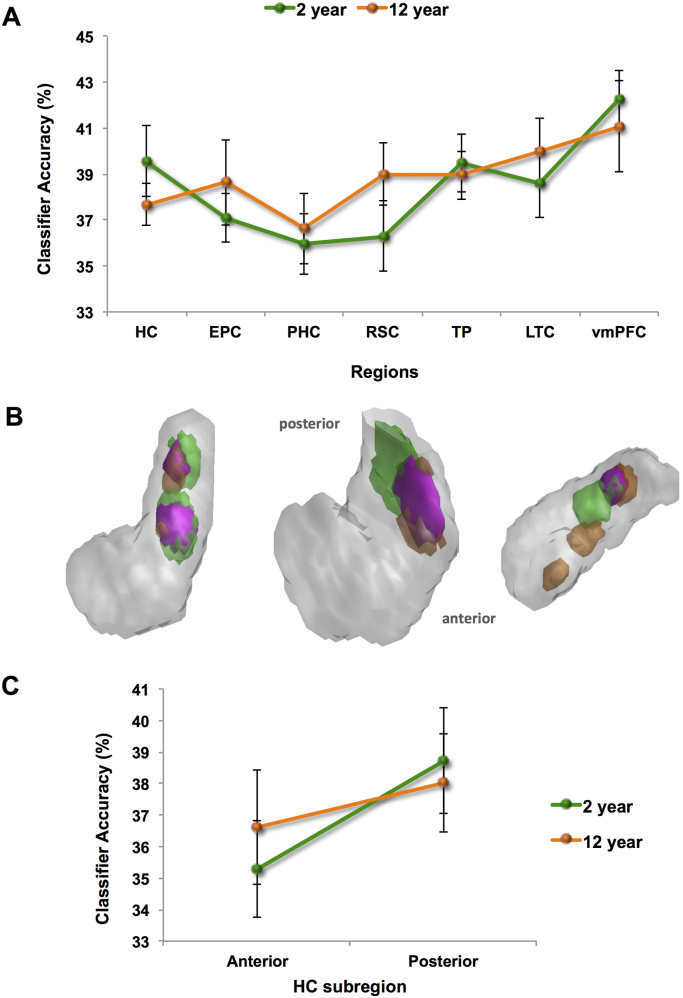
MVPA results for recent and remote autobiographical memories in study two. A. Hippocampus (HC), entorhinal and perirhinal cortices (EPC), parahippocampal cortex (PHC), retrosplenial cortex (RSC), temporal pole (TP), lateral temporal cortex (LTC), and ventromedial prefrontal cortex (vmPFC) were examined. Chance=33%. Two year old (green line) and 12 year old (orange line) autobiographical memories were represented in medial temporal regions, including the hippocampus. In study two, this was also the case for vmPFC. Error bars represent ±1 standard error of the mean. B. Information maps in the hippocampus for 2 year old (shown in green) and 12 year old (shown in orange) autobiographical memories comprised the voxel sets that produced above-chance classification accuracy. The information maps for three example participants are shown superimposed upon 3D images of their right hippocampus. Areas in pink denote where the information maps for the 2 year old and 12 year old memories overlapped. C. MVPA results for anterior and posterior subregions of the hippocampus (HC). No differences between memory types were apparent in either the anterior or posterior hippocampus. Error bars represent ±1 standard error of the mean. (For interpretation of the references to color in this figure legend, the reader is referred to the web version of this article.).